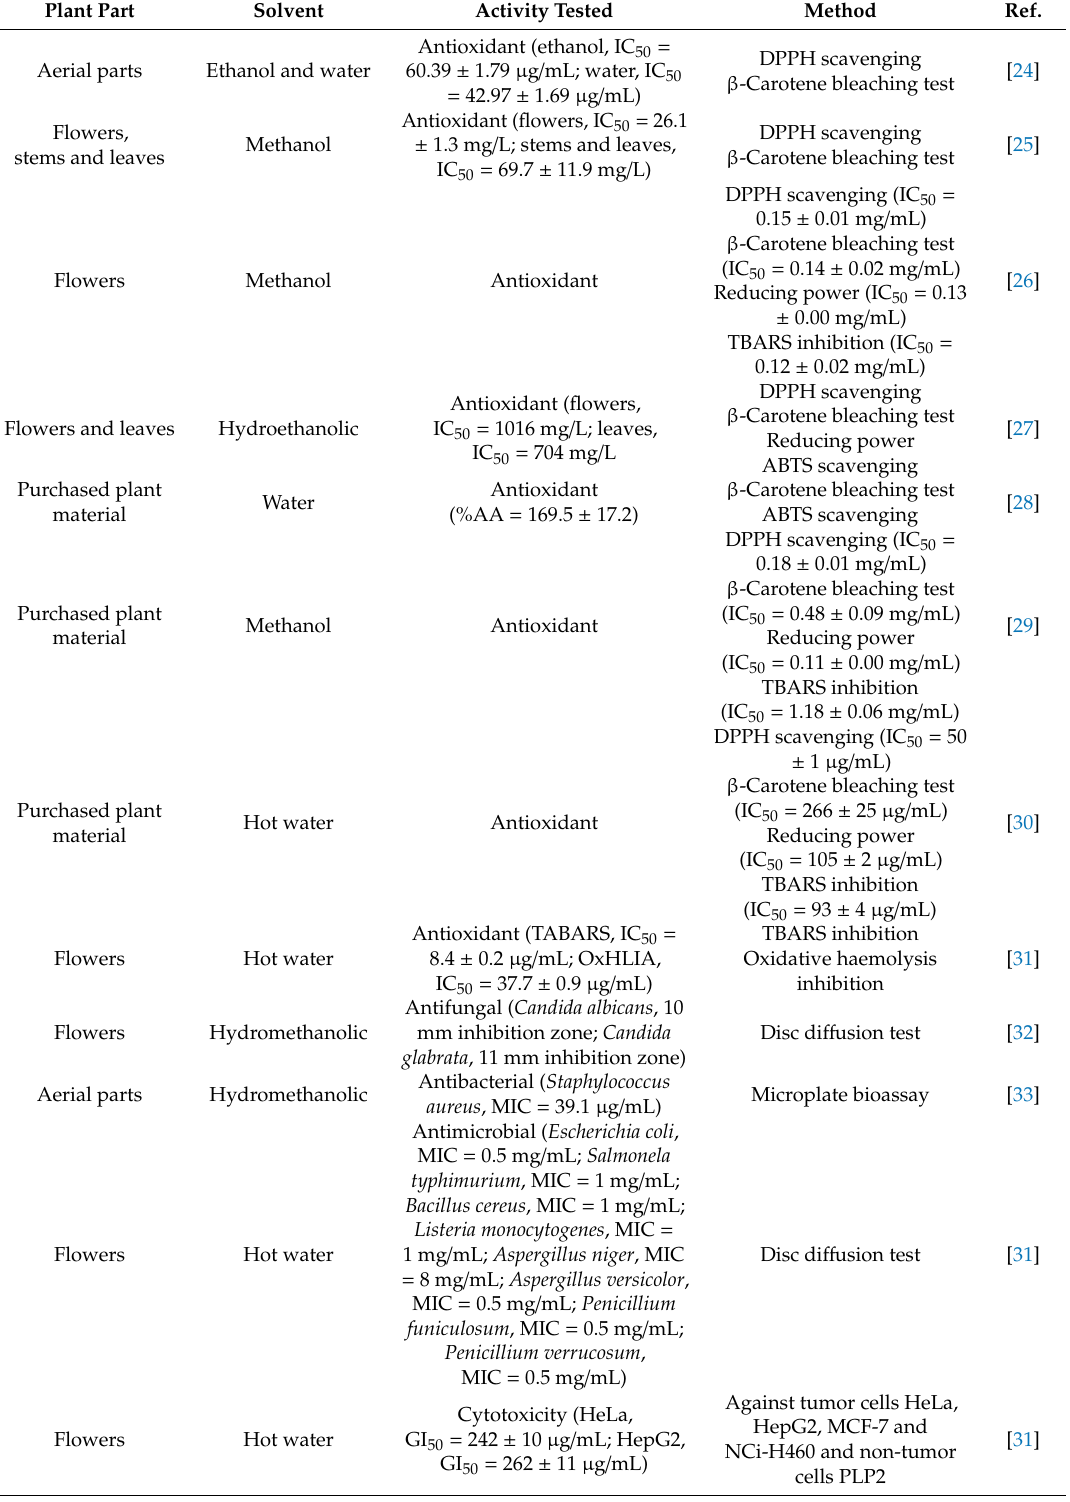
Table 1. Biological assays of Genista tridentata